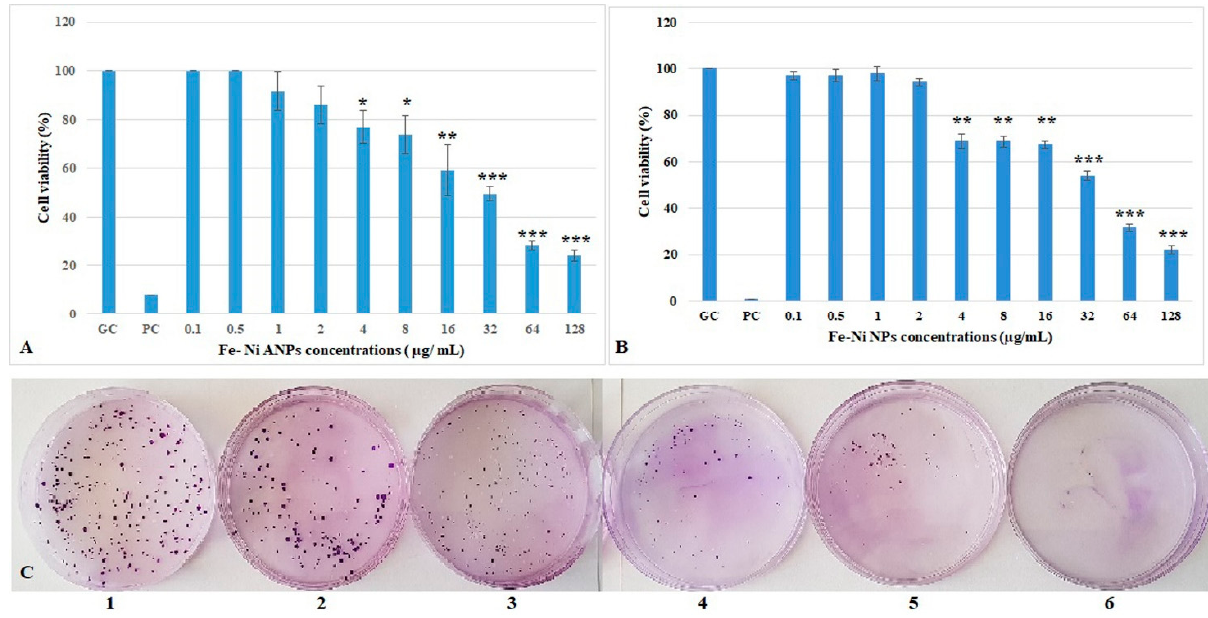
Figure 2. Viability of Beas-2B cells treated with Fe-Ni ANPs for 24 h. ( A ) Results from XTT. ( B ) Results from clonogenic assay. ( C ) Sample images of the clonogenic assay. 1 : growth control; 2 : 1 µ g/mL Fe-Ni ANPs; 3 : 2 µ g/mL Fe-Ni ANPs; 4 : 32 µ g/mL Fe-Ni ANPs; 5 : 128 µ g/mL Fe-Ni ANPs; 6 : positive control. GC: growth control; PC: positive control (3 µ M H 2 O 2 ). Data represent the average value of three independent XTT and clonogenic assays. Error bars: the standard deviation of the mean. Asterisk: significantly different from the control (*: p < 0.05; **: p < 0.01;***: p < 0.001).